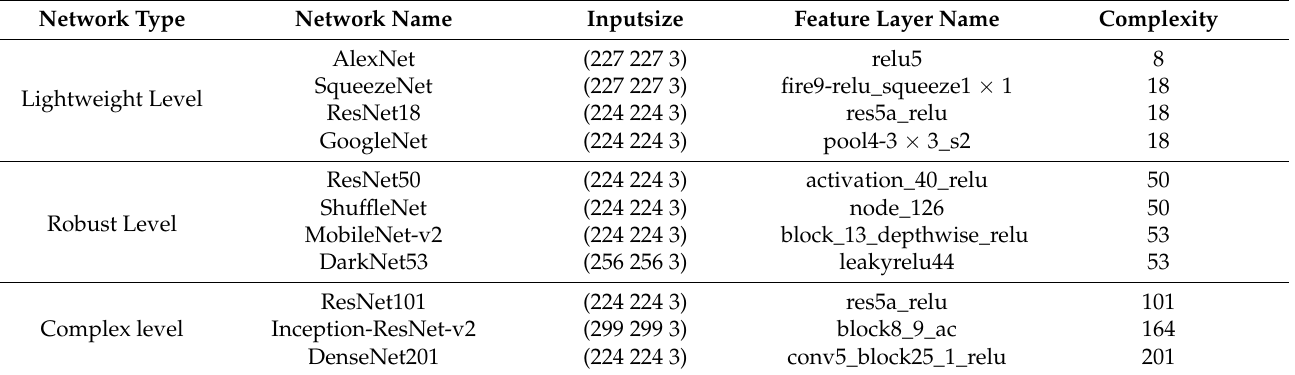
Table 2. Basic situation of feature extraction